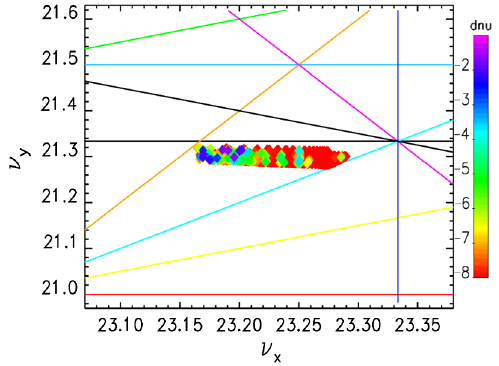
FIG. 8. Betatron tune footprint with the color indicating the tune diffusion d